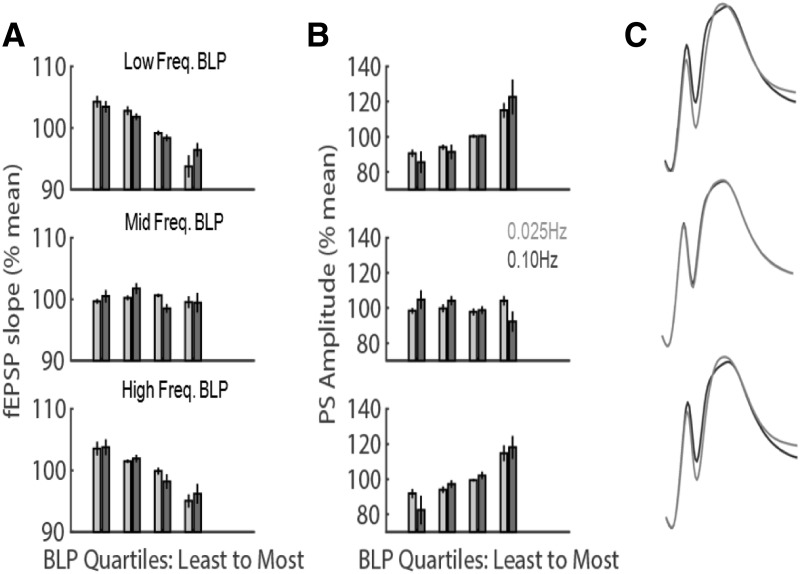
fEPSP slope (A) and PS amplitude (B) as a function of preceding low-, middle-, or high-frequency BLP quartiles and stimulation frequency (0.25 or 0.10 Hz). C, Average evoked responses from an individual rat for responses following spontaneous EEG epochs that contained the least (black) and most (gray) BLP for each condition.